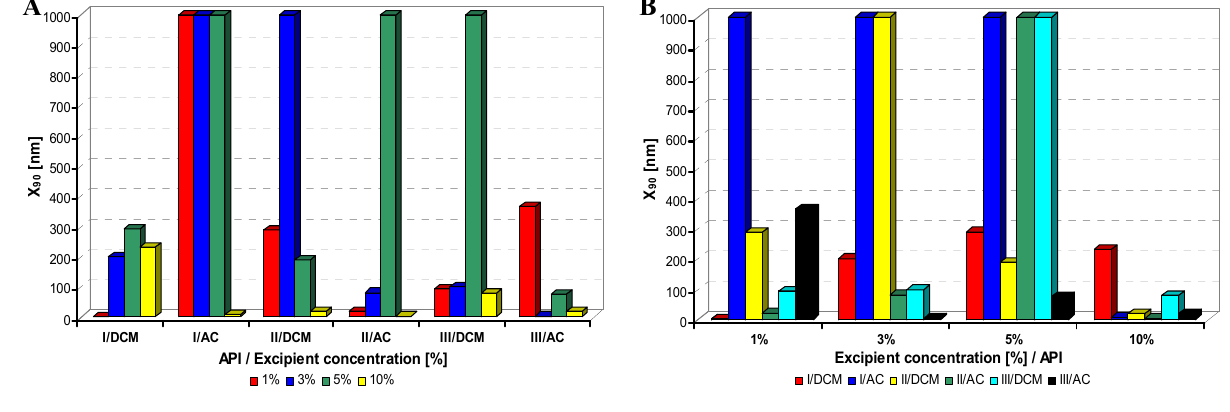
Figure 2. Dependence of particle size (x [nm]) of model APIs I – III on concentration [%] 90 of Tween 80 in dichloromethane (DCM) or acetone (AC). ( A ) Samples are grouped according to APIs; ( B ) samples are grouped according to excipient percentage. For clarity sake, the values on y-axis are only to 1,000